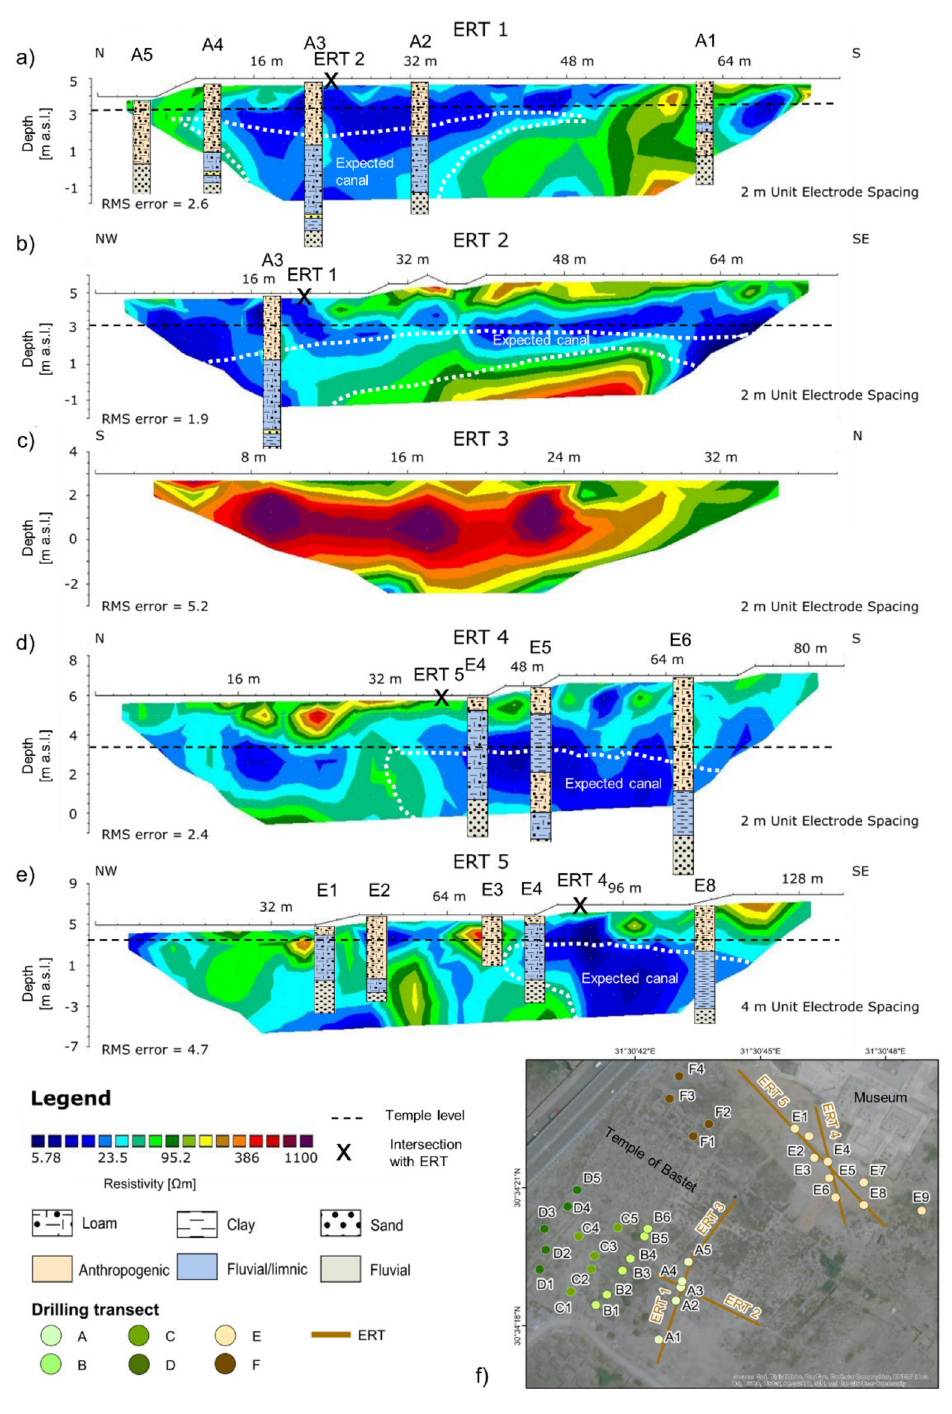
Figure 6. 2D Electrical Resistivity Tomography (ERT) profiles and drilling locations ( f ). The profiles ERT 1 and 2 are located south of the Temple of Bastet ( a , b ); profile ERT 3 is located in the center of the Temple of Bastet ( c ) and the profiles ERT 4 and 5 are located between the northern border of the Temple of Bastet and the museum ( d , e ). The dashed black line marks the ground level of the Temple of Bastet in the 1st millennium BCE (3.35 m a.s.l.). The dashed white line marks the extent of the expected